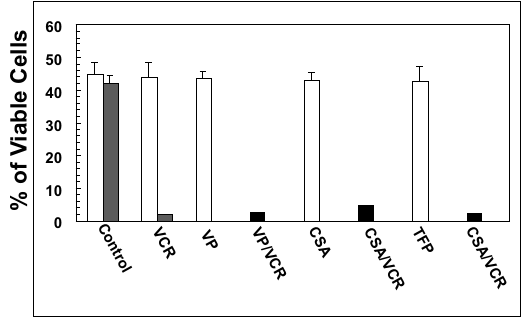
Fig. 3 – Reversal of the resistance to vincristine by MDR mod- ulators. Lucena 1 cells were incubated for 7 days with vin- cristine (VCR 60 nM) in the presence of verapamil (VP 5 µ M), cyclosporin A (CSA 200 ng/ml) or trifluoperazyne (TFP 5 µ M) andthenumberofremainingviablecellswascountedunderphase microscopy. For comparison, in black are the number of viable cells of K562 control or treated by the same time with